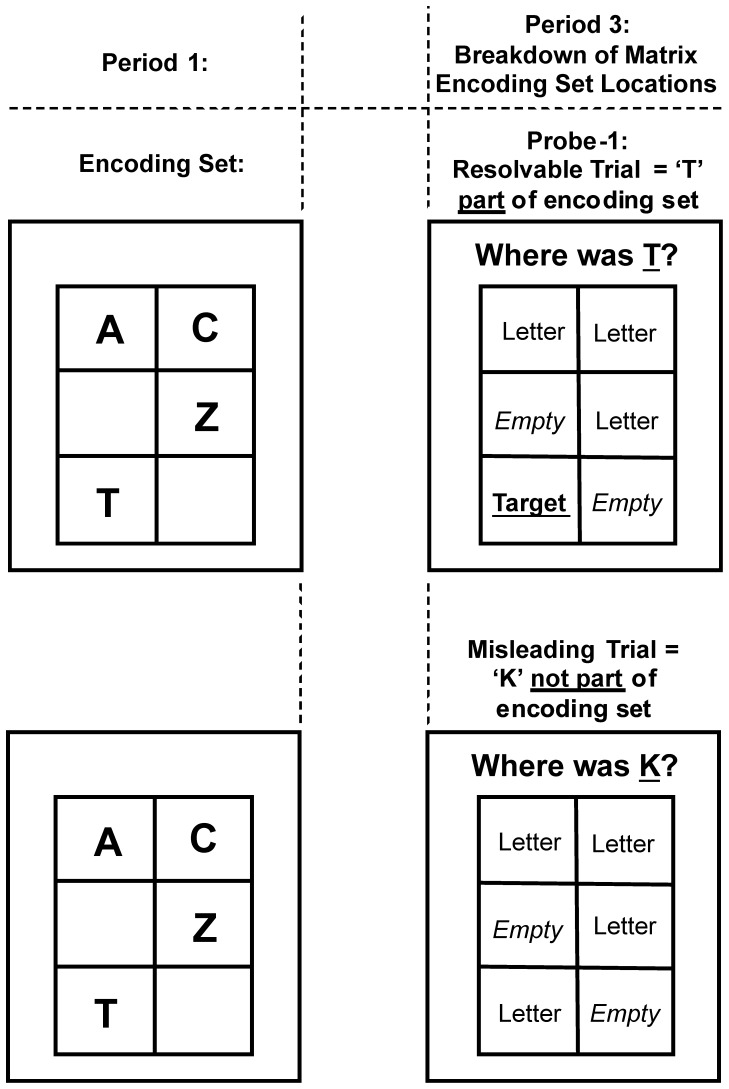
Breakdown of Period 3 analysis.In Period 3 an empty matrix was shown together with Probe-1 that could be either resolvable (top) or misleading (bottom) The matrix entries during Period 3 were then re-labelled in terms of what they had contained during encoding: ‘empty’, ‘letter’ or ‘target’ – with the latter only possible for resolvable trials.